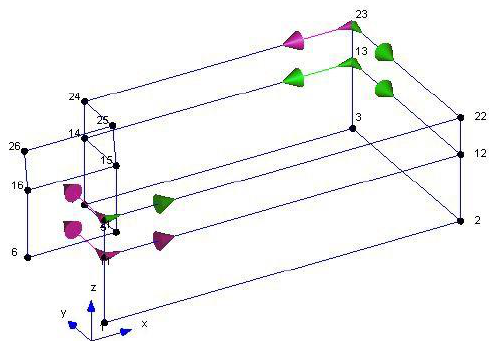
Figure 6. Geometry of Structure A for Operational Modal Analysis (OMA) along with accelerometers positions and directions.